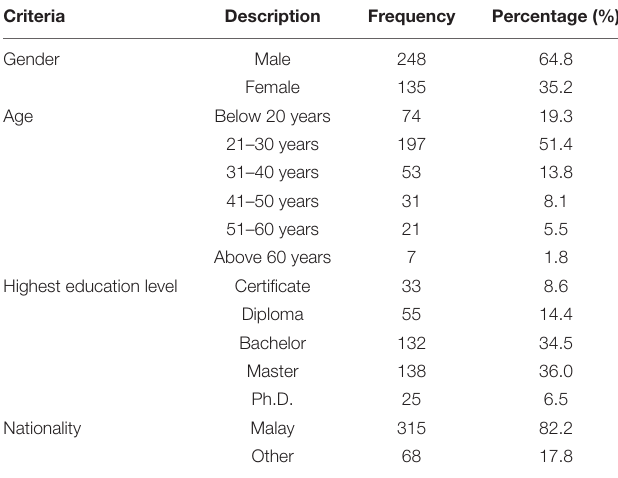
TABLE 3 | Respondent’s